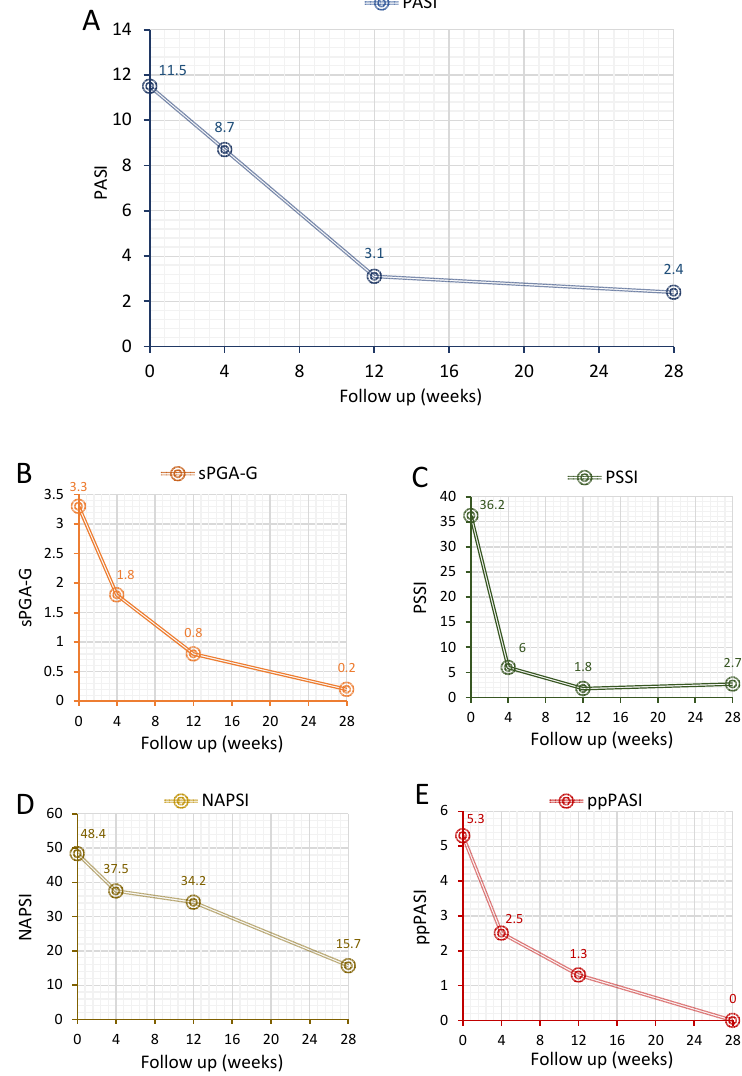
Figure 1. Effect of tildrakizumab in psoriatic patients on disease activity measures. ( A ) PASI response, ( B ) sPGA-G response, ( C ) PSSI response, ( D ) NAPSI response and ( E ) ppPASI response. Data are presented as mean scores based on 18 patients treated with tildrakizumab over 28 weeks. PASI = psoriasis area severity index; sPGA-G = static Physician’s Global Assessment of Genitalia; PSSI = Psoriasis Scalp Severity Index; NAPSI = Nail Area Psoriasis Severity Index and ppPASI = Palmoplantar Psoriasis Area and Severity Index.